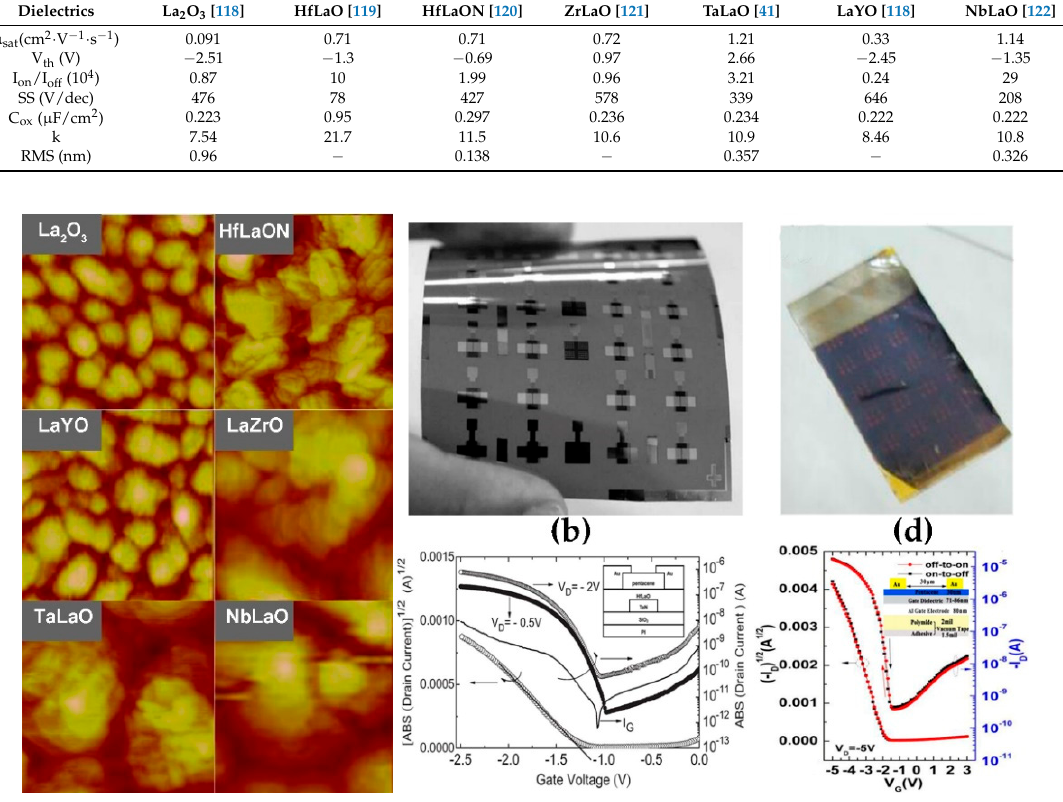
Table 4. Characteristics of pentacene OTFTs with La-based high-k gate dielectrics. Dielectrics